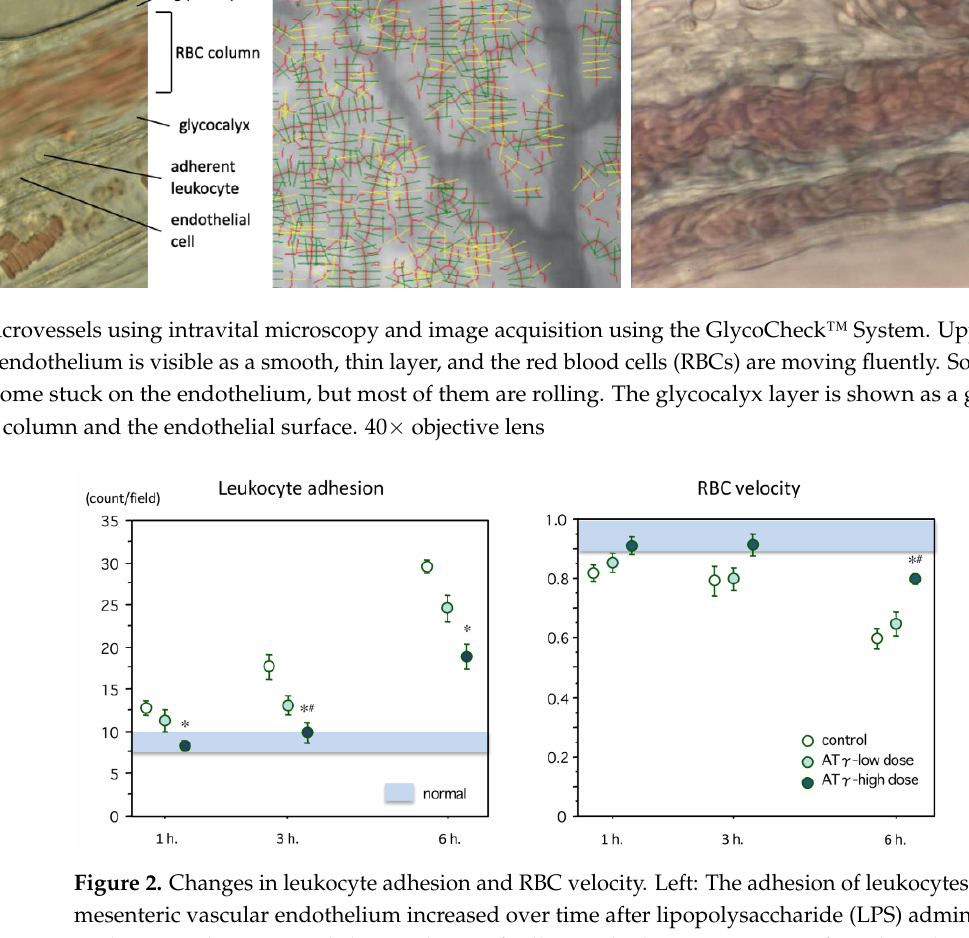
Figure 2. Changes in leukocyte adhesion and RBC velocity. Left: The adhesion of leuko-